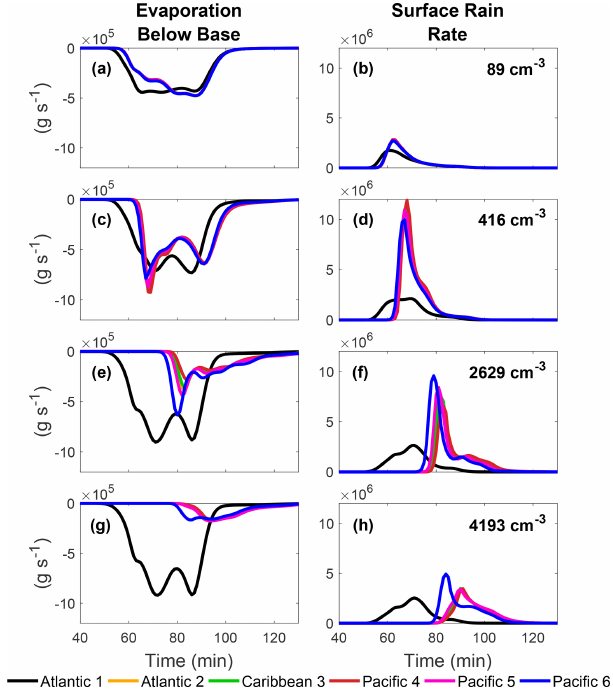
Figure 3. Time evolution of the evaporated mass below the cloud base and surface rain mass per unit time (left and right columns, respectively). Each row represents a specific N tot : 89cm − 3 (a, b) , 416cm − 3 (c, d) , 2629cm − 3 (e, f) , and 4193cm − 3 (g, h) , as shown in the upper right corner of each row. The different curves in each panel represent an MSD shape normalized to the specific N tot . Note that there is an order of magnitude difference between the exponent in the right and left